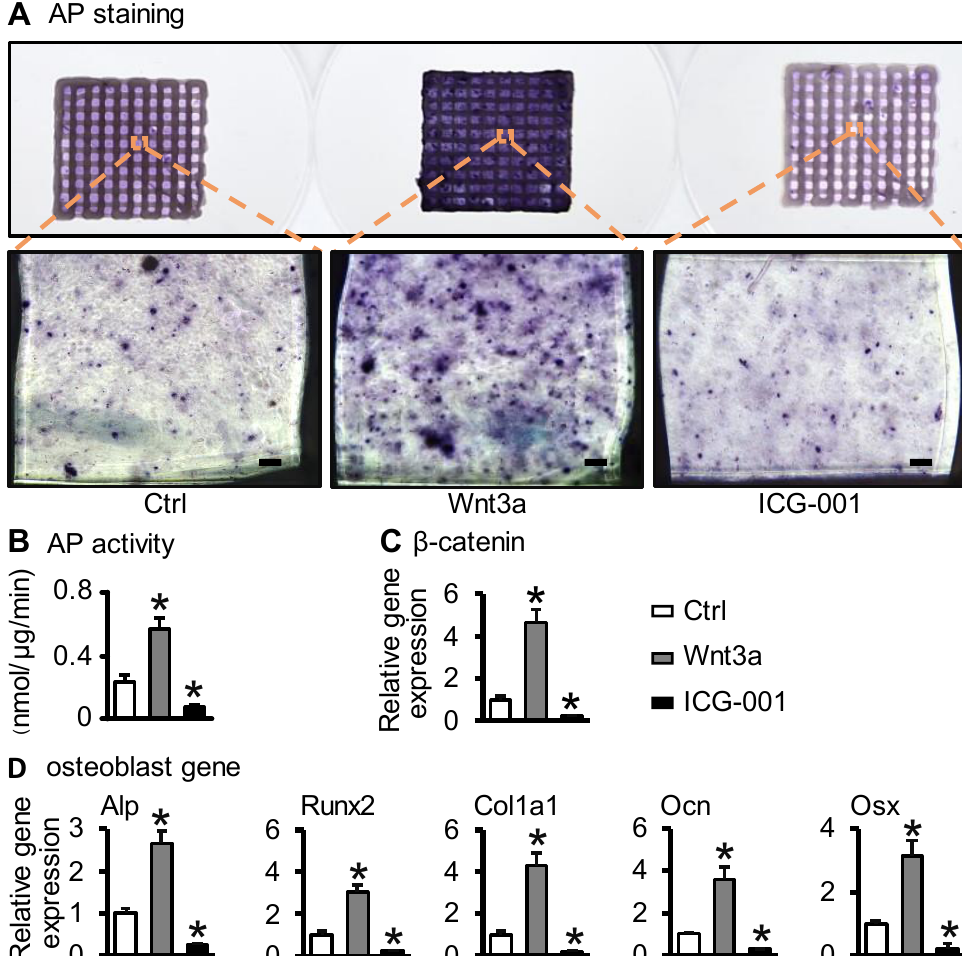
Figure 4. Wnt3a pretreatment enhanced osteogenic differentiation of ST2/GelMA/PCL scaffolds. The test was performed on the seventh day of scaffold culture. ( A ) Alkaline phosphatase staining and ( B ) Alkaline phosphatase activity quantification. ( C ) The expression of the key factor β -catenin of Wnt signaling and ( D ) osteogenic marker genes (Alp, Runx2, Col1a1, Ocn, Osx). Compared with the ctrl group, * p < 0.05 by one-way ANOVA. n = 3. (Scale bar: A, 100 µm).